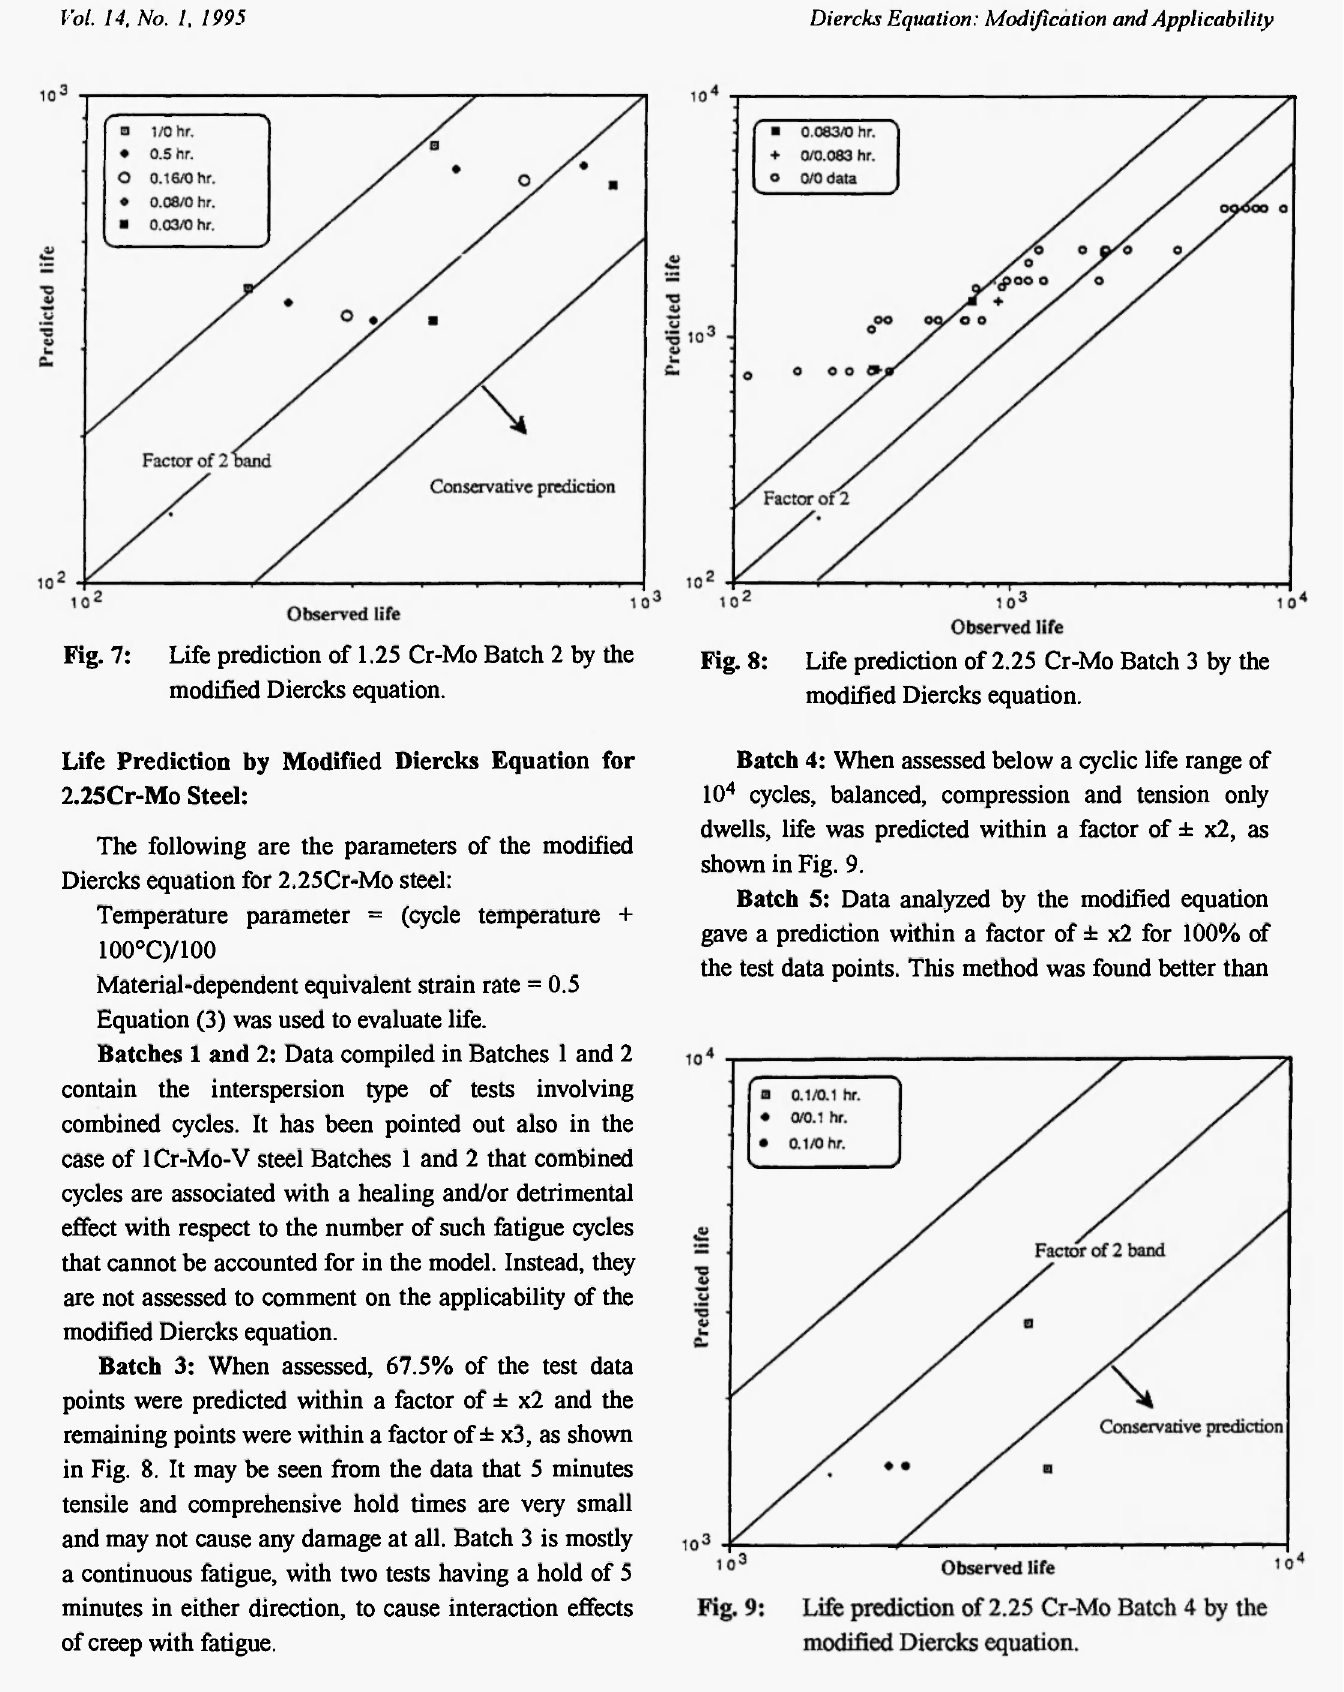
Fig. 7: Life prediction of 1.25 Cr-Mo Batch 2 by the modified Diercks equation.